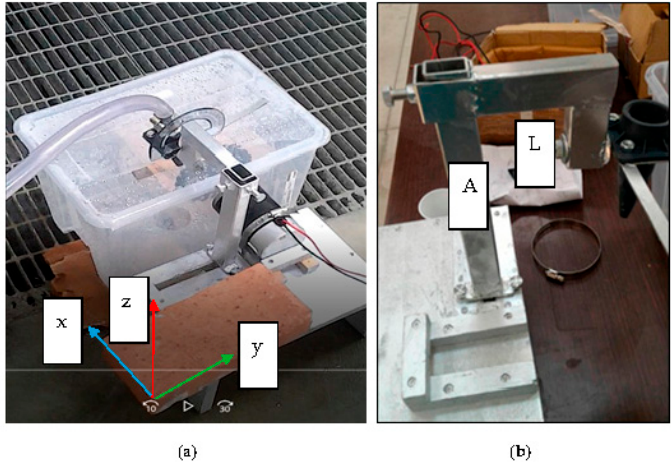
Figure 2. ( a ) Reference system on the structure; ( b ) The adjustable support connected to the nozzle.